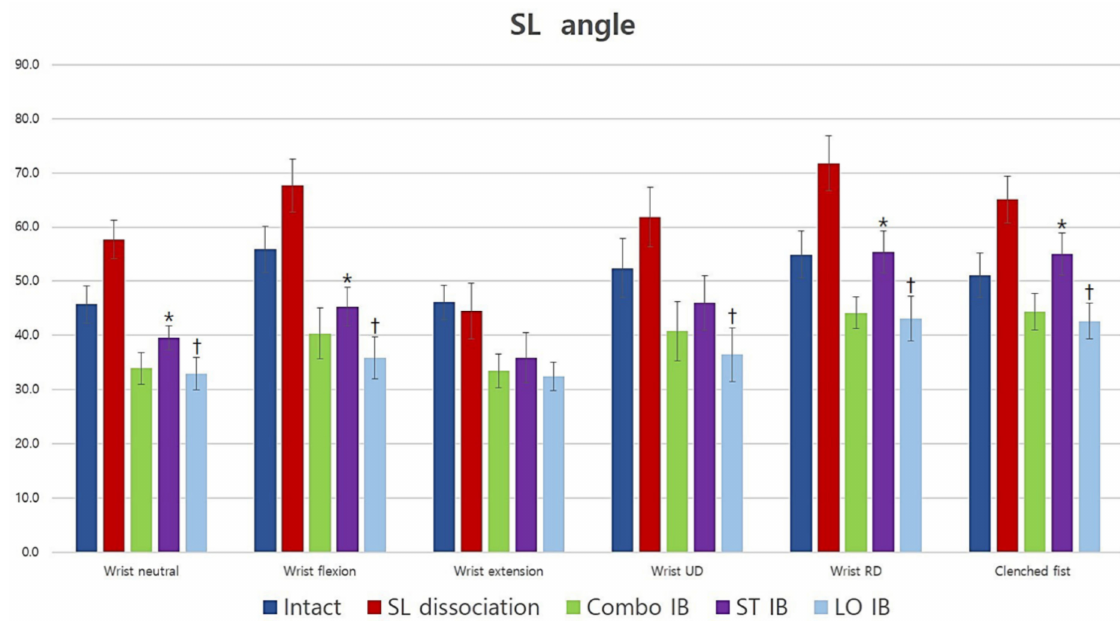
Figure 6. The average scapholunate angle for all conditions and positions (degrees). Short-transverse IB had less effect than long-oblique and Combo IB; however, long-oblique and Combo IB had similar effects. *: Statistically significant difference compared to Combo IB ( p < 0.05), †: Statistically significant difference compared with short-transverse IB ( p < 0.05) SL: scapholunate; UD: ulnar deviation; RD: radial deviation; Combo: combination; IB: internal bracing; ST: short-transverse; LO: